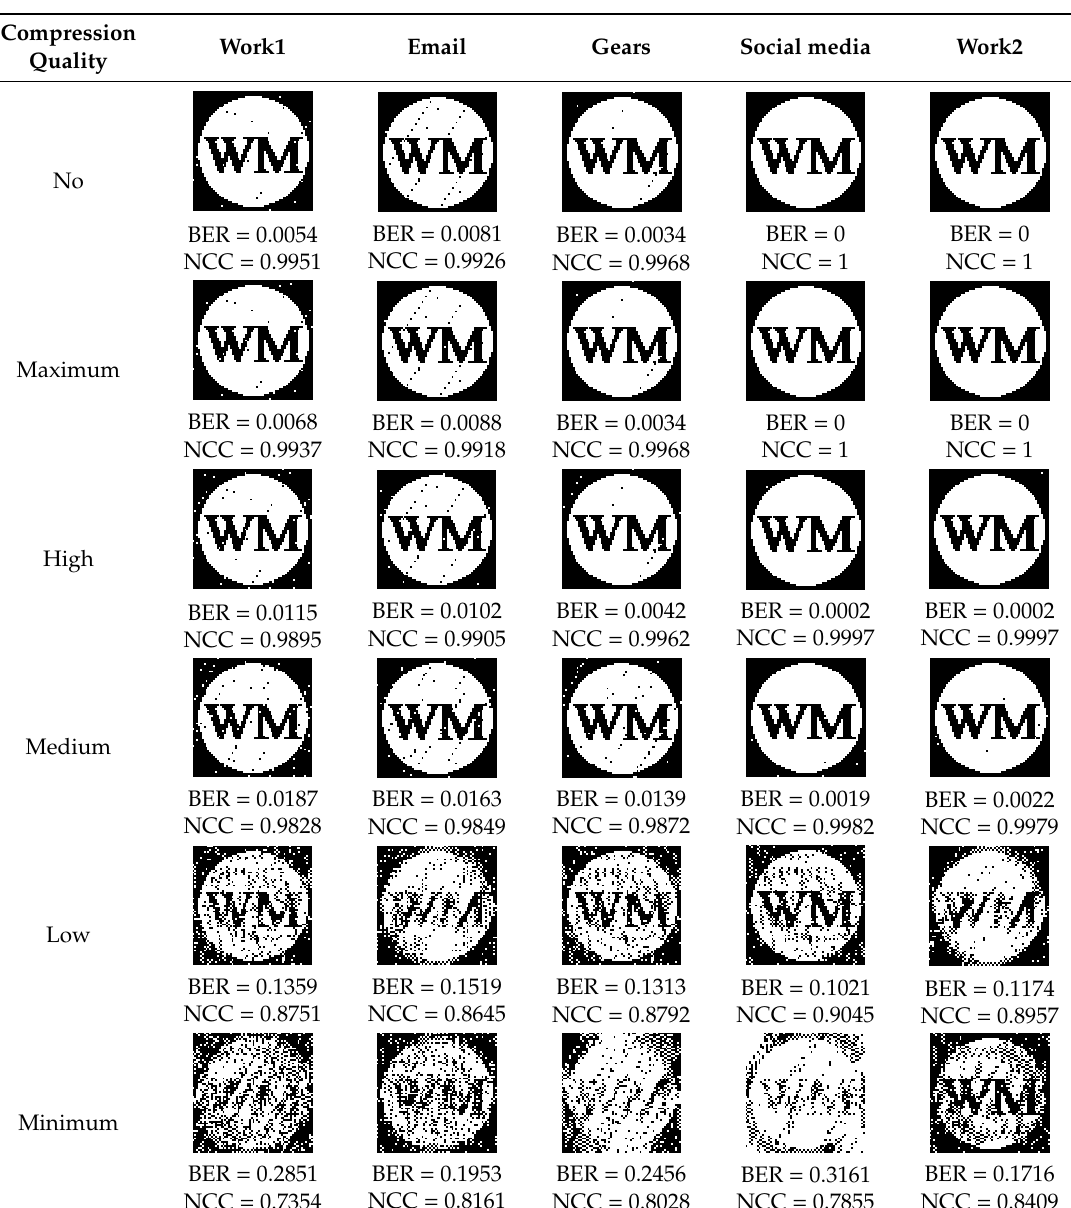
Table 2. Watermarks extracted from highly detailed watermarked images obtained by the algorithm [31].